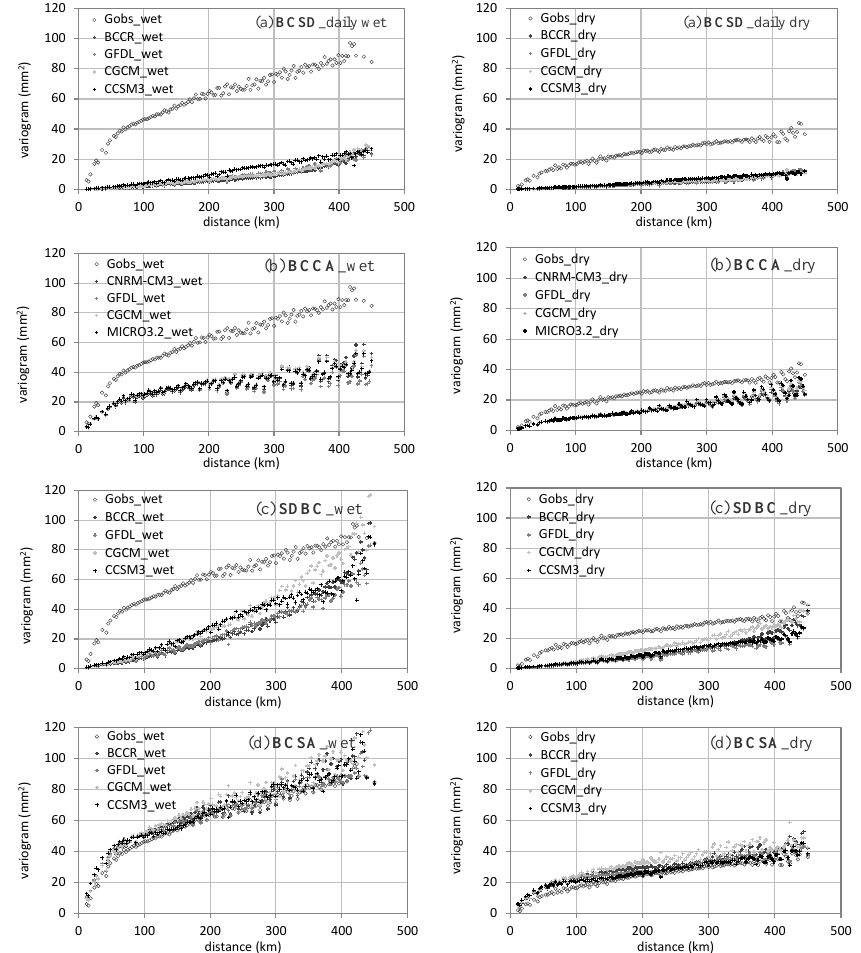
Fig. 18. Variogram comparison of (a) BCSD_daily, (b) BCCA, (c) SDBC, and (d) BCSA daily precipitation predictions for wet (left column, June through September) and dry season (right column, October through